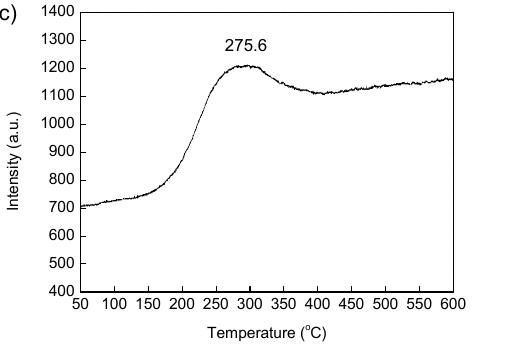
Figure 2. The NH 3 -TPD curves of MIL-101 ( a ); TiO 2 ( b ); and C ( c ).